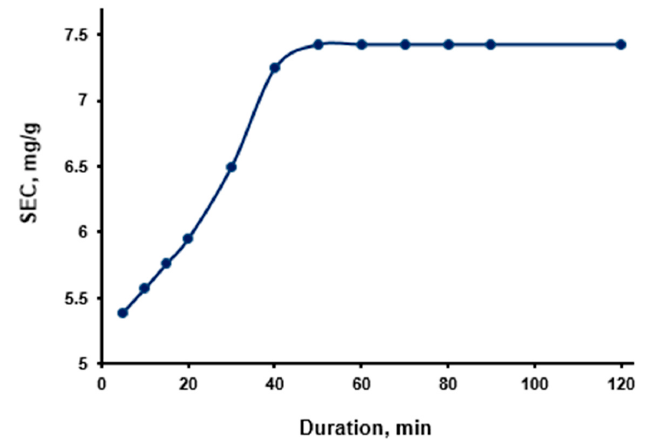
Figure 8. Dependence of SEC value on contact duration on AB-17-8 anion-exchange resin.